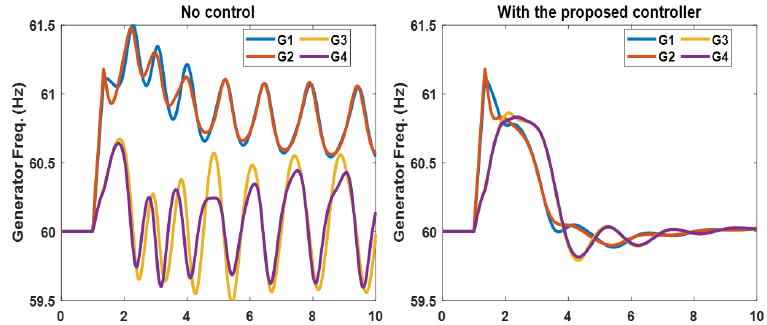
Figure 14. Generator frequency with no control and with control.